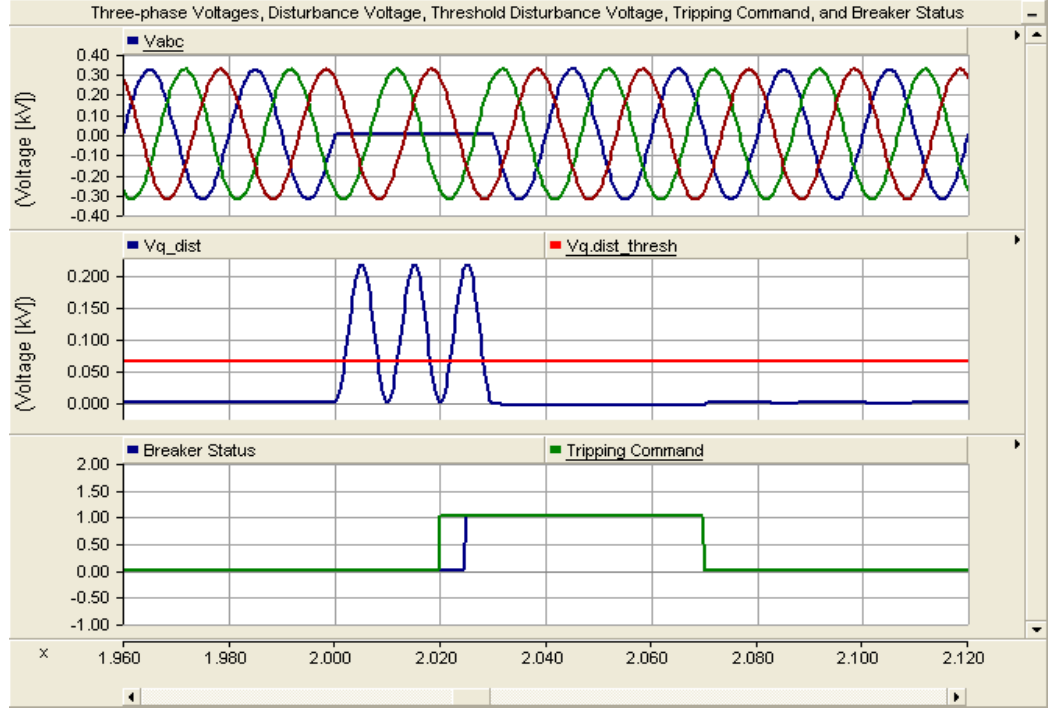
Figure 5. 3-phase voltages, disturbance voltage, and trip signal for F3.